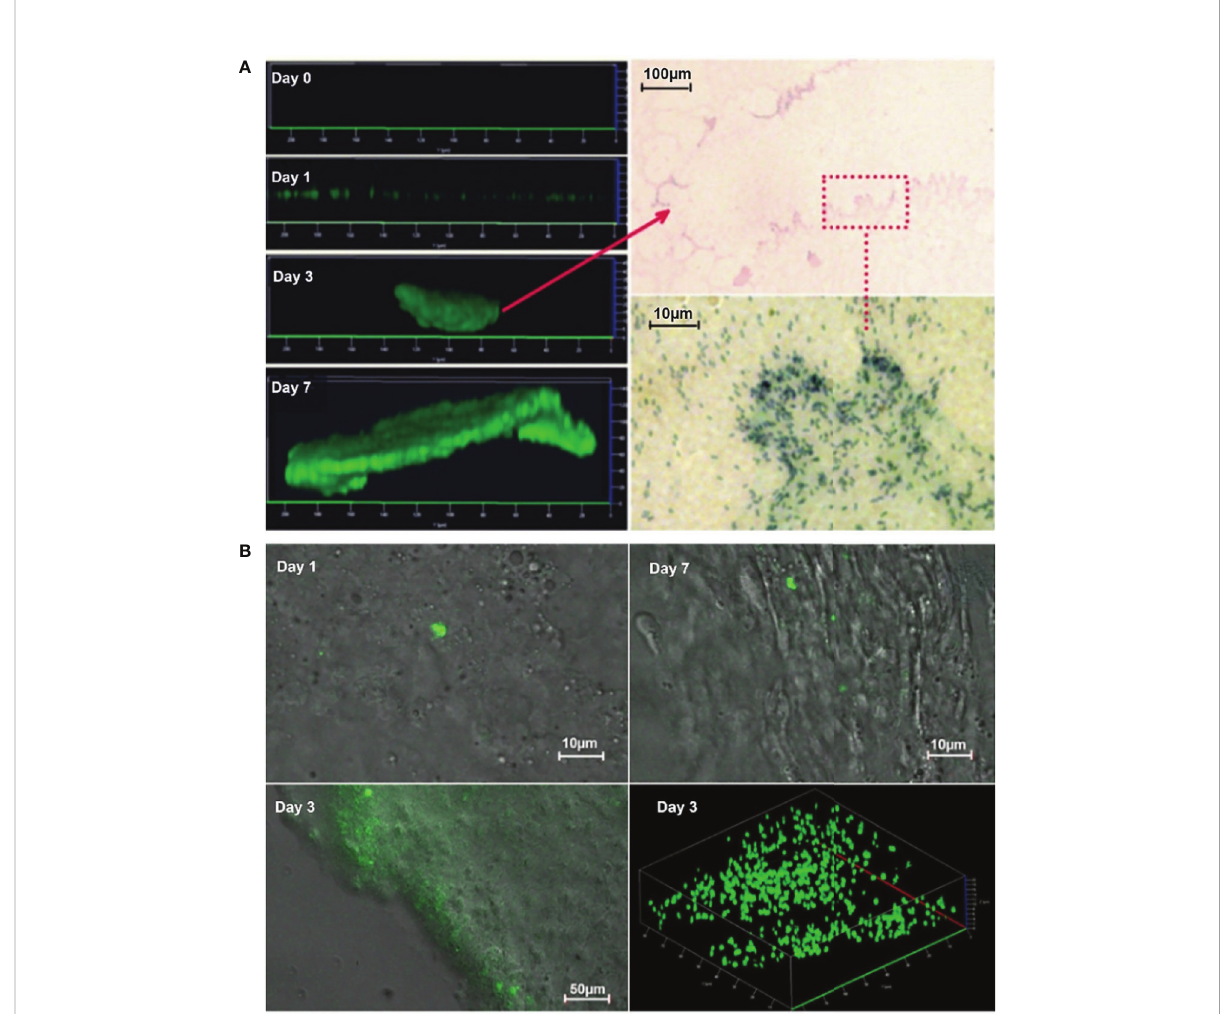
FIGURE 1 Development of P. aeruginosa bio fi lm in PF hydrogel in vitro (A) and in vivo ( B ). (A) Left panel: CLSM micrographs visualize clearly that P. aeruginosa PAO1 (labeled with GFP) develops bio fi lms progressively from single bacteria (almost no signal due to limited number of bacteria) at day 0, further to microcolonies at day 1 that increased in size at days 3 and 7. Right panel: Images taken by light microscopy of methylene stained day 3 bio fi lms show distinct bio fi lm structures and single bacterial cells inside the PF hydrogel. The red arrow points toward a microcolony in the upper image and the bacteria in the red rectangle area are visualized by higher magni fi cation in the lower image. (B) Epi fl uorescence and merged epi fl uorescence/light images acquired in frozen sections of PF hydrogel implants harvested from mouse peritoneal cavities. PAO1 (labeled with GFP) formed fi rst single microcolonies at day 1 and then developed bio fi lm in an extensive area at day